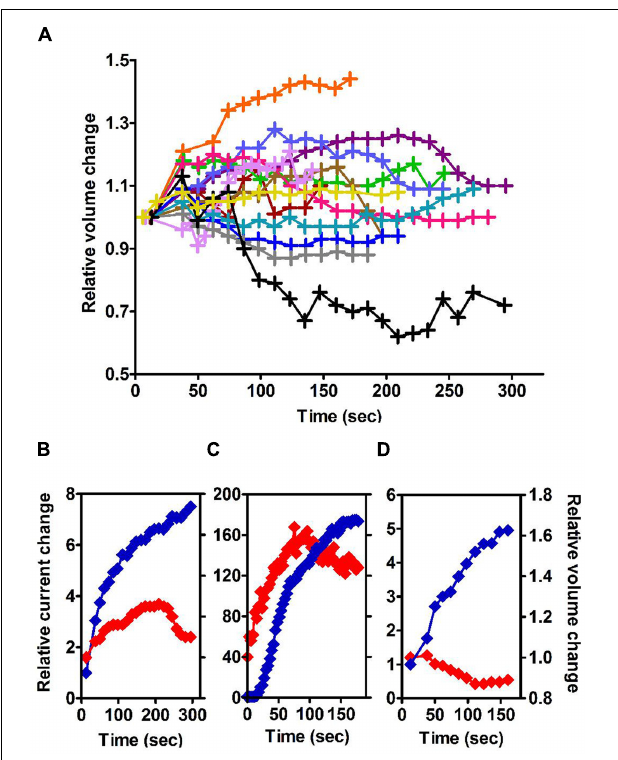
FIGURE 3 | (A) Time courses of change in cell volume following the establishment of whole-cell recording conditions under iso-osmotic conditions in 13 human neutrophils carried out in solution set B ( Table 1 ). (B–D) Three examples of clear divergence between relative changes in volume and current amplitudes. All measures are normalized to their initial values. Blue traces represent the relative current change (left y axis). Red traces represent the relative volume change (right y axis). Experiments for (B,D) used human neutrophils and were carried out in solutions set B, while solution set C was used for (C) and was recorded in a mouse neutrophil ( Table 1 ).